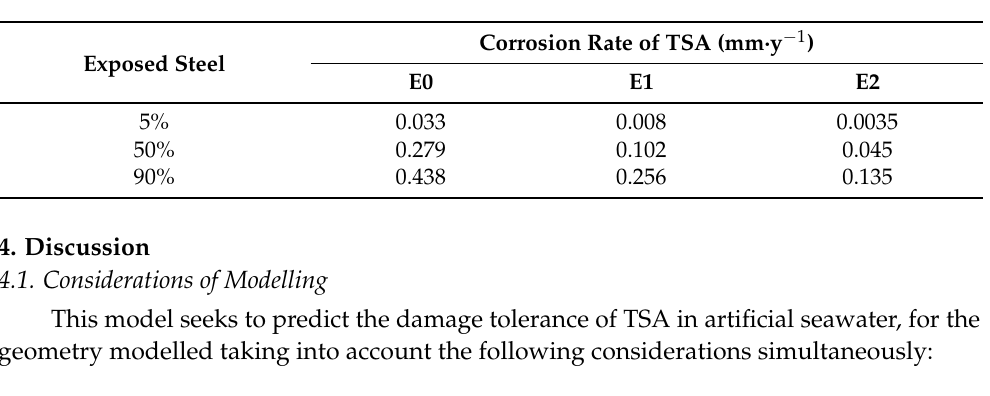
Table 3. Corrosion rates calculated from the